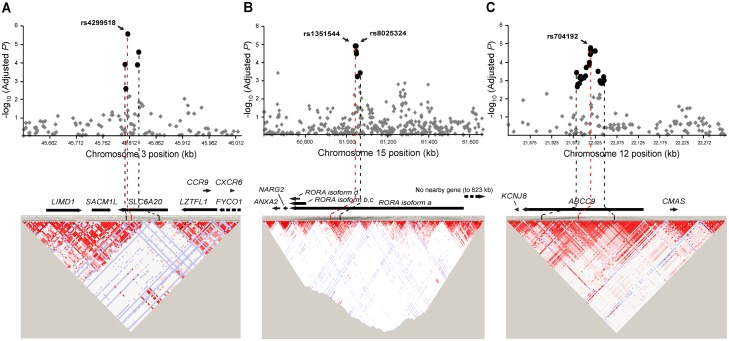
Regional association and LD plots of SLC6A20, RORA, and ABCC9 SNPs for HSCR.Associations of SNPs across approximately (A) a 400 kb region around SLC6A20 on chromosome 3p21.3, (B) a 1,065 kb region around RORA on chromosome 15q22.2, and (C) a 500 kb region around ABCC9 on chromosome 12p12.1, under analysis adjusted by RET-CSGALNACT2-RASGEF1A and NRG1, are shown. In the upper panel of each regional association, strong associations are shown as large black circles; relatively weak associations are shown as small gray diamonds. In the lower panel, LDs are indicated with LD coefficient (r2) between all pairs of biallelic loci.